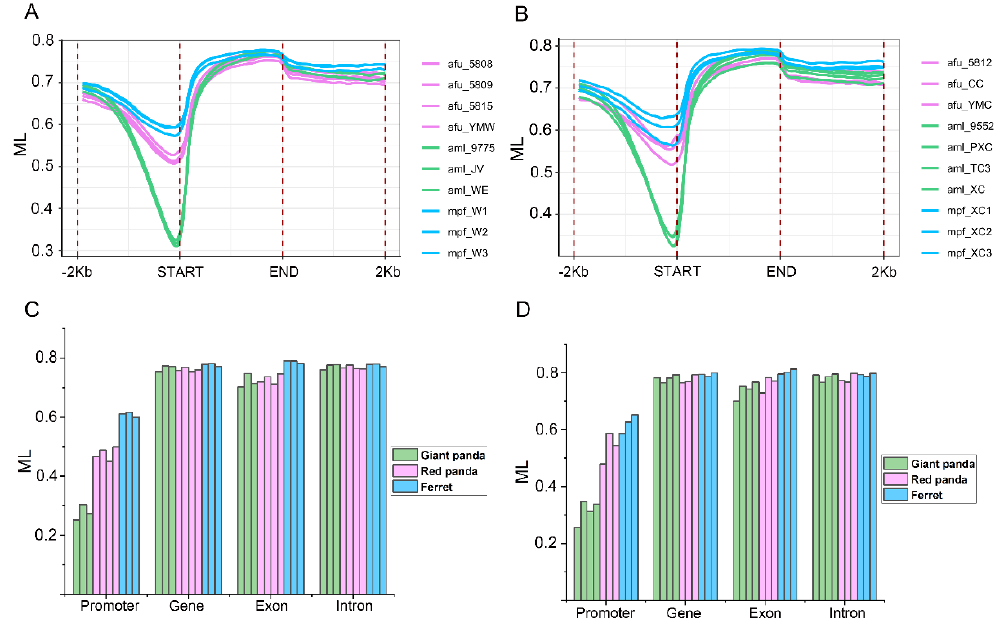
Figure 6. The DNA methylation patterns and levels. The methylation pattern diagram of gene regions with upstream 2000 bp and downstream 2000 bp regions in the stomach ( A ). The methylation pattern diagram of gene regions with upstream 2000 bp and downstream 2000 bp regions in the small intestine ( B ). The mean CG methylation levels in different gene elements including promoter, gene, exon and intron in the stomach ( C ). The mean CG methylation levels in different gene elements including promoter, gene, exon and intron in the small intestine ( D ).